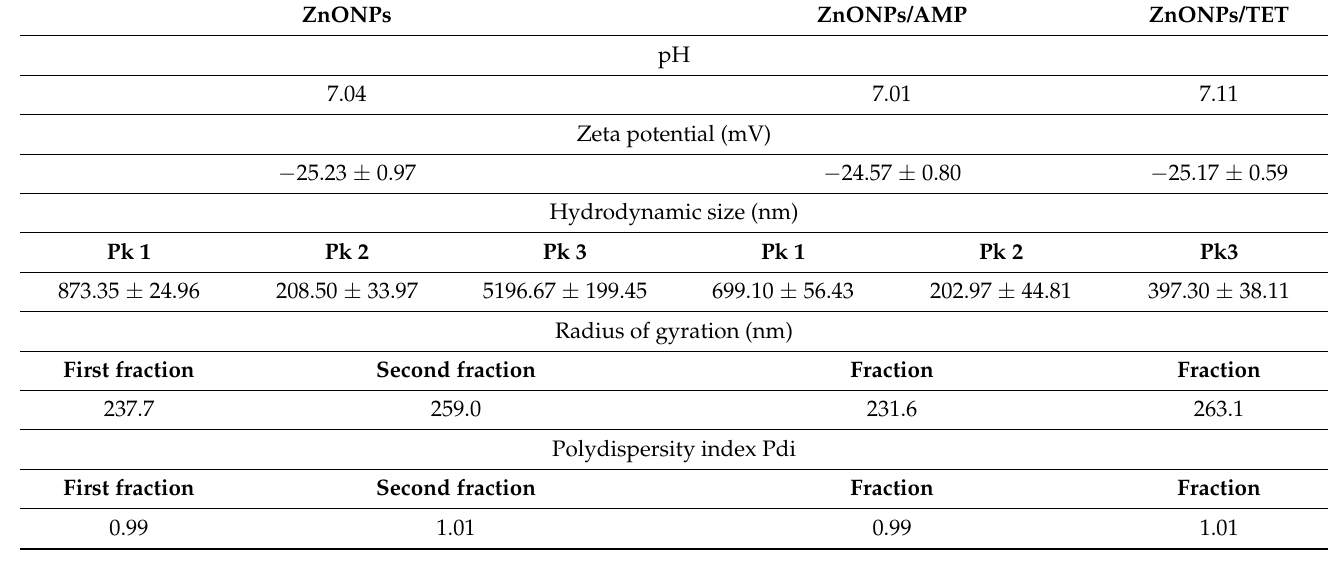
Table 3. The pH, zeta potential, average hydrodynamic size, radius of gyration and polydispersity index of each population value of zinc oxide nanoparticles, non-immobilized and immobilized with ampicillin and tetracycline.